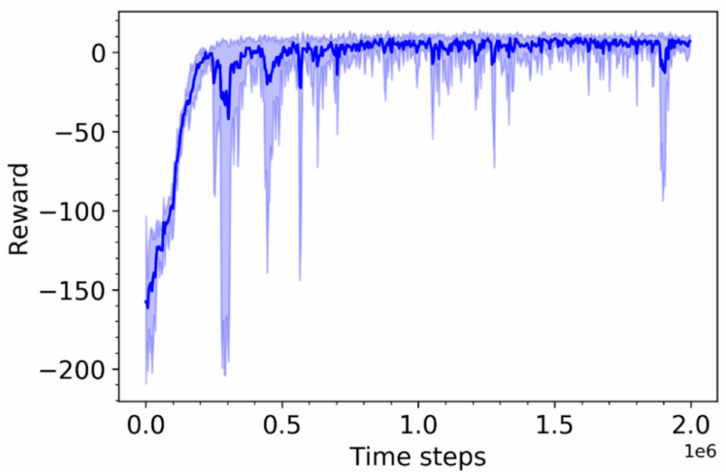
Figure 6. Training progress over six runs with different random seeds for Agent